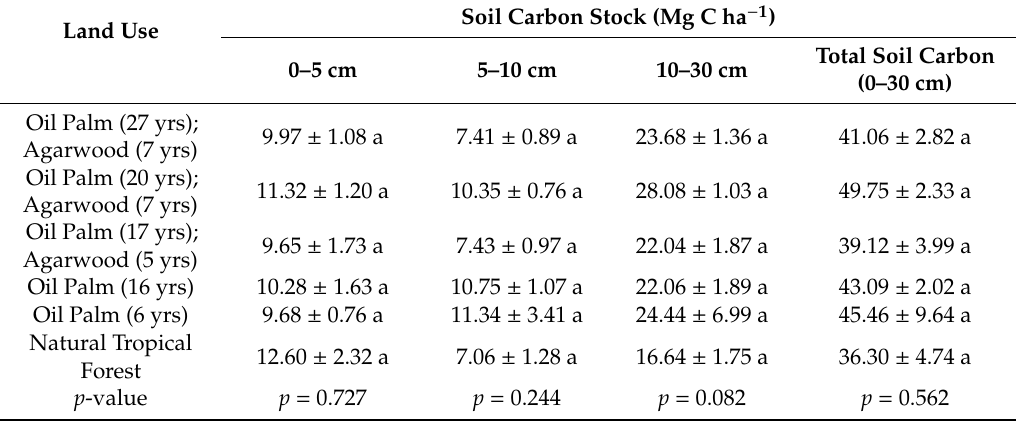
Table 3. Soil carbon stock in di ff erent soil layers of di ff erent land